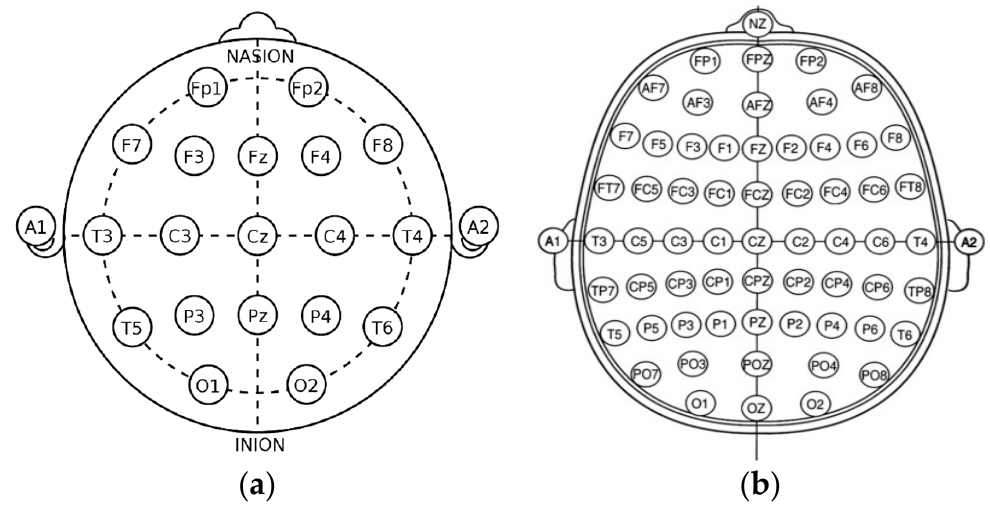
Figure 2. The basic view of the international system of EEG node placement: ( a ) 10/20 system; ( b ) 10/10 system.